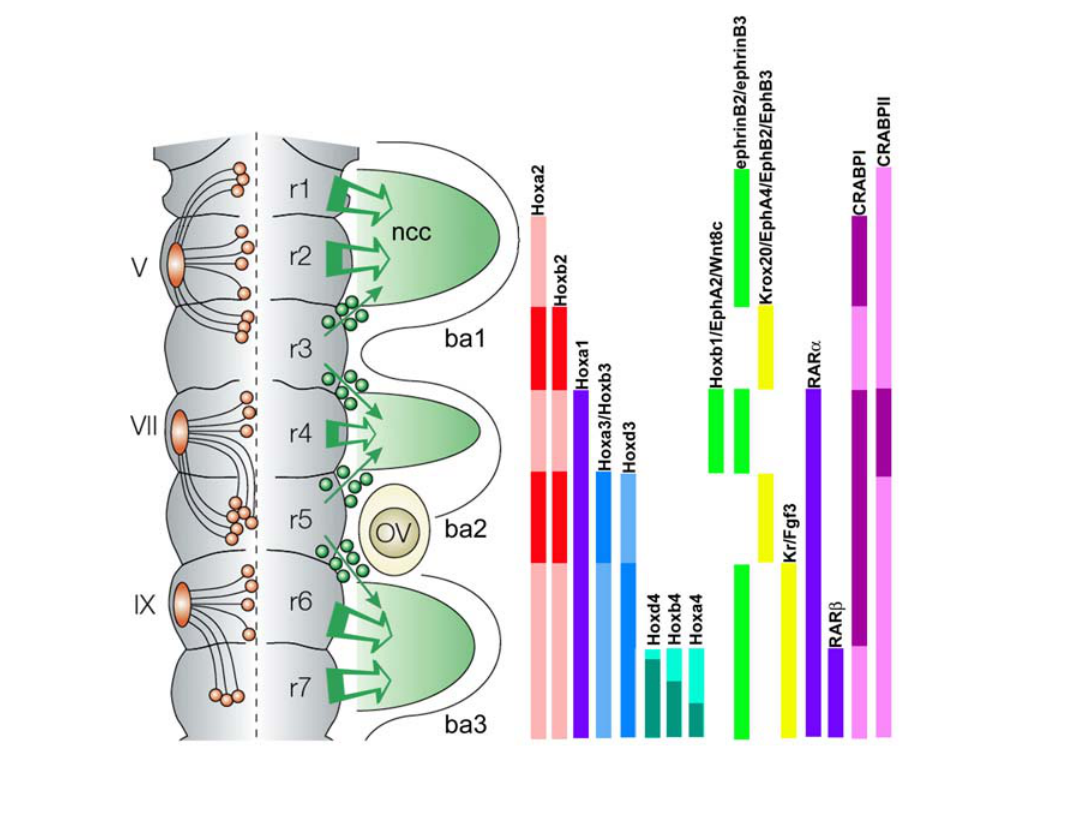
FIGURE 1 . Segmentation of the hindbrain, motor nerves, and pathways of neural crest cell (ncc) migration. The vertebrate hindbrain becomes subdivided into 7 transient rhombomeres (r) which presages the segmental organization of the branchiomotor nerves, III (trigeminal), V (facial), and VII (glossopharyngeal) and their innervation of the first (ba1), second (ba2), and third (ba3) branchial arches, respectively. Although the cell bodies (small red circles) that make up each branchiomotor nerve are derived from multiple rhombomeres, their axons project and leave the neural tube only from exit points contained within the even numbered rhombomeres (large red circles). Neural crest cells derived from the hindbrain (large green arrows) migrate ventrolaterally in three segmental streams adjacent to the even-numbered rhombomeres and into the branchial arches. Neural crest cells derived from the odd-numbered rhombomeres do not migrate laterally, rather they migrate anteriorly or posteriorly to join the even-numbered neural crest streams. The hindbrain segmentation process which establishes each rhombomere as a unit of cell lineage and the subsequent imposition of cell fate identity corresponds with the activation of expression, of genes from multiple families, such as Hox , Eph/ephrin , RAR and CRABP families. The patterns of gene expression are extremely dynamic and only the primary pattern for each gene between 8.5– 10.5dpc is shown here. The only exception is Hoxa1 which is expressed up to the presumptive r3/4 boundary at 7.5dpc but is subsequently switched off before rhombomere formation. OV, otic